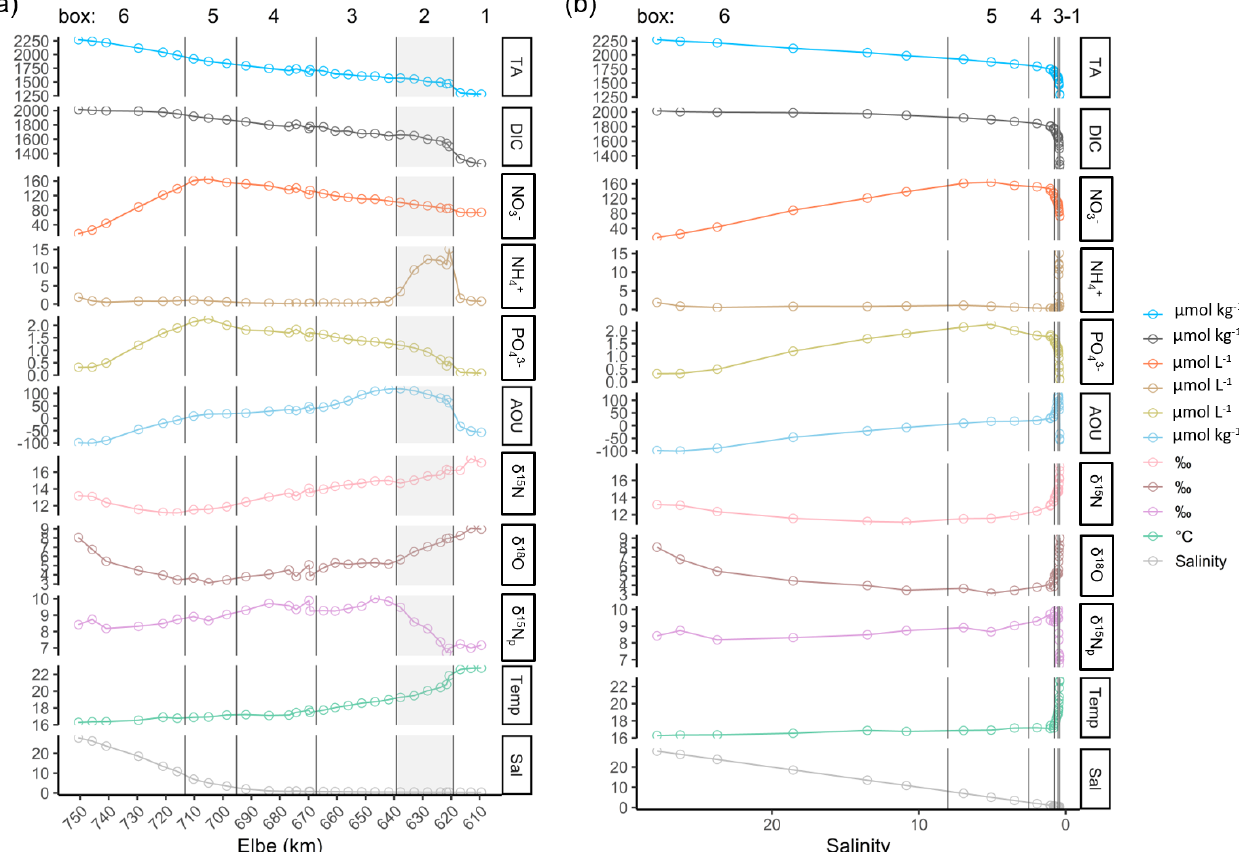
Figure 3. Spatial- and salinity-dependent observed parameter distribution along the Elbe Estuary. The data are from 2d in June 2019. (a) Spatial observed parameter distribution from the inner estuary (Elbe stream km 609, right side) to the German Bight around the island of Scharhörn (computed Elbe stream km 750, left side). Total alkalinity (TA), dissolved inorganic carbon (DIC), nitrate (NO − ) , phosphate (PO 3 − ) , apparent oxygen utilization (AOU), and delta values of nitrate isotopes ( δ 15 N, δ 18 O), of filtered water, and of (NH + 4 4 suspended particulate matter ( δ 15 N p ), as well as temperature (Temp; in ◦ C) and salinity (Sal), are shown. The vertical lines indicate the designated boxes for the mass balance calculation, in which the inner boundary (box 1) is on the right side of the plot, followed by the shaded box 2 with the Hamburg port area (upper estuary), boxes 3 and 4 (middle estuary), box 5 (lower estuary), and the outer marine boundary (box 6) on the left side of the plot. (b) Salinity-dependent observed parameter distribution. Note the different y -axis scales within the different panels of both